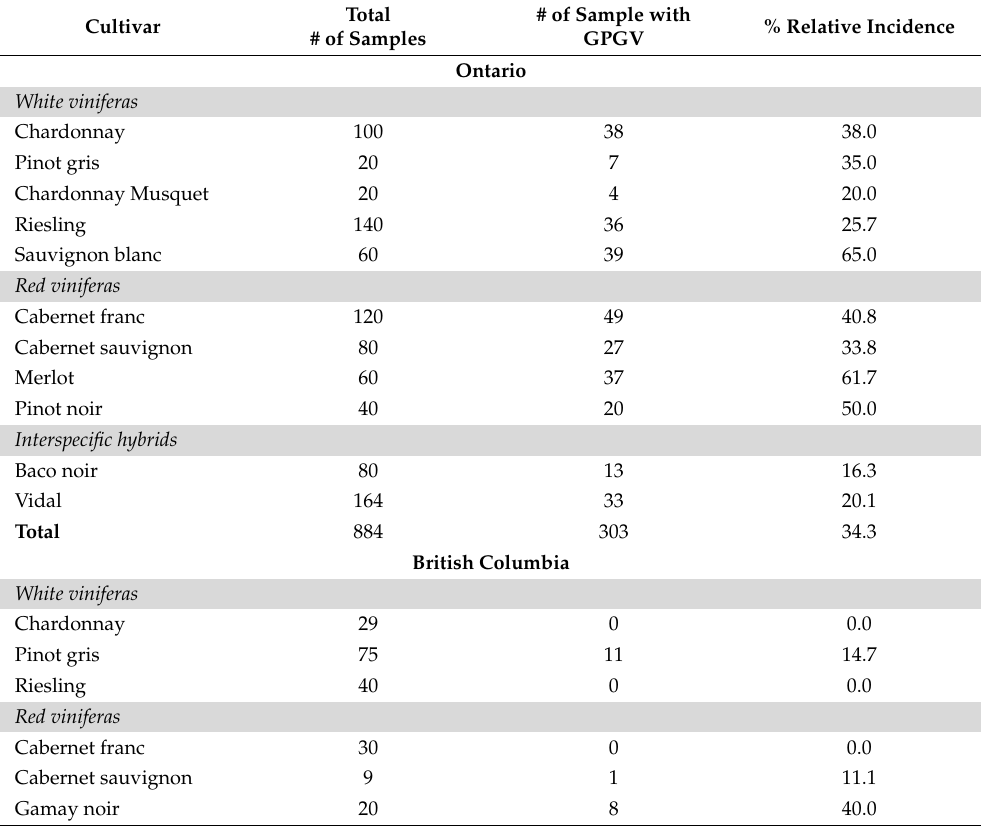
Table 1. Survey results from ON and BC for GPGV in different